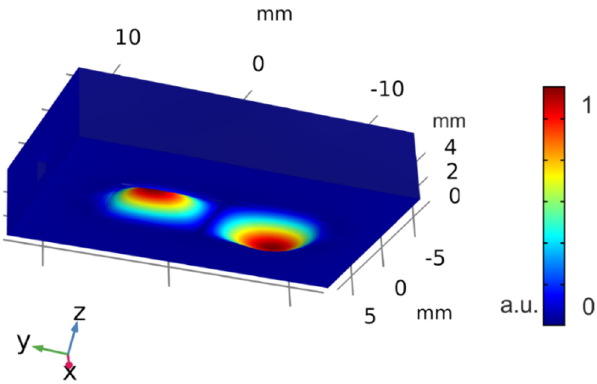
Figure 2. Simulation results from the modal analysis showing the 32 − mode shape in the piezoelectric actuated side of the cell. The color scale represents the amplitude of deformation in arbitrary units.